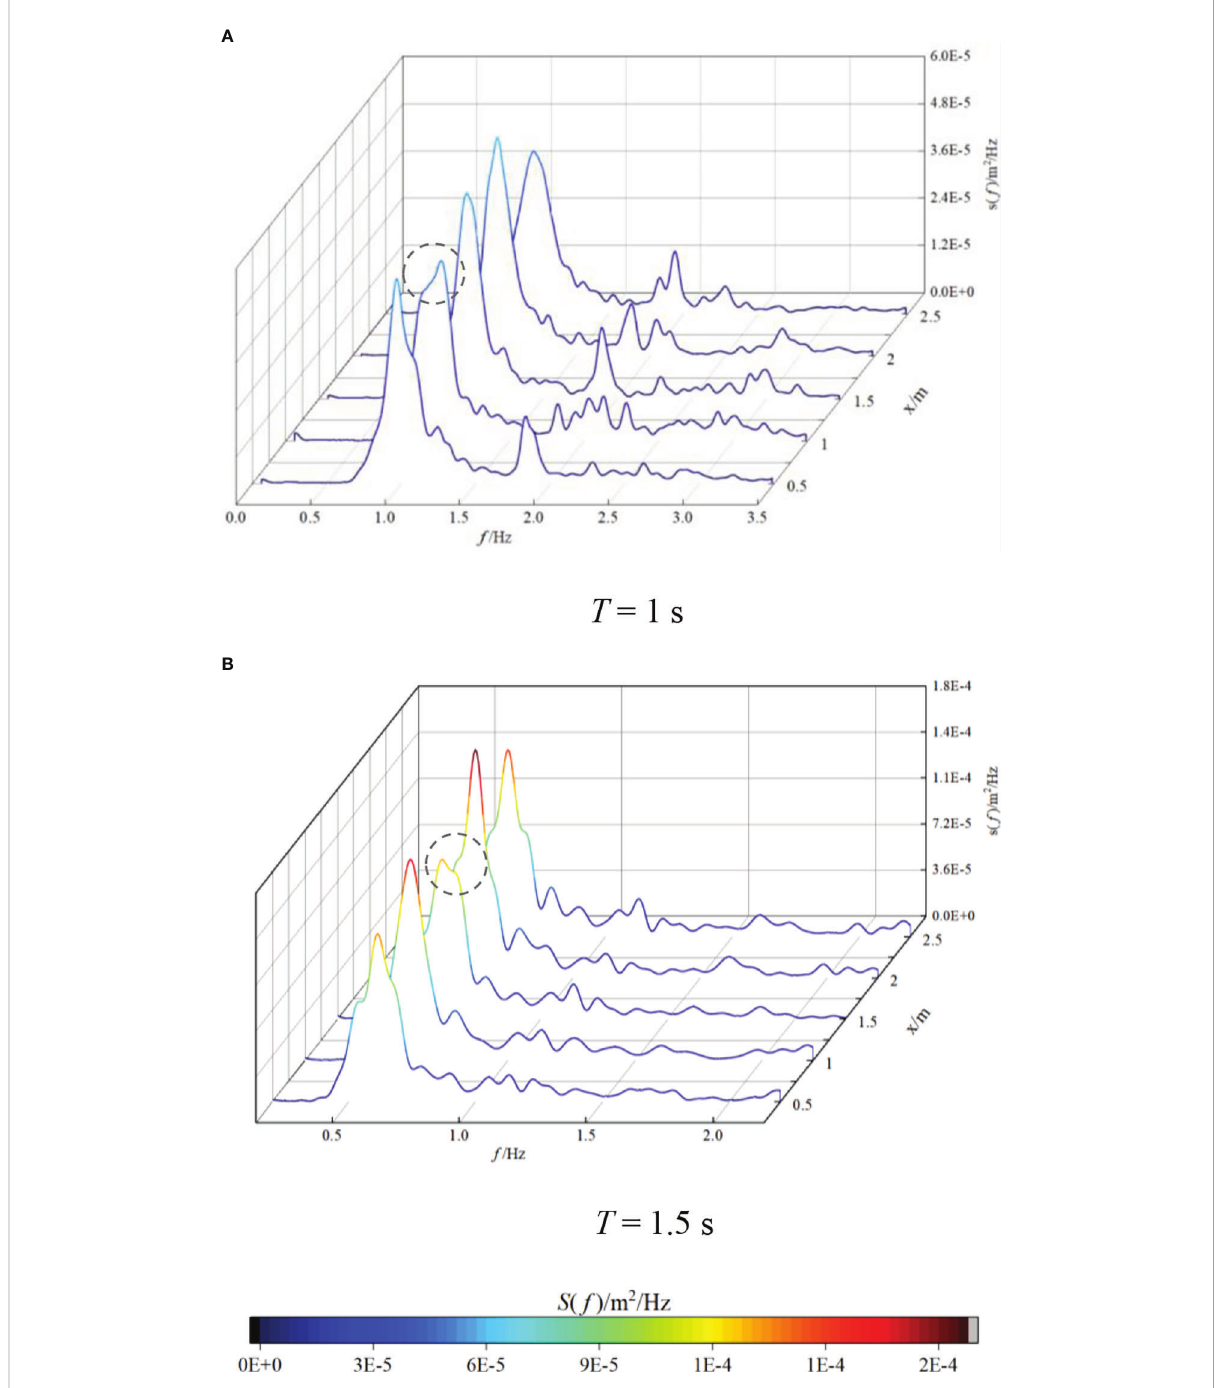
FIGURE 7 Comparison of wave energy spectra at different propagation distances (M1, D = 0.27 m, H i = 0.043 m) (A) T = 1 s (B) T = 1.5